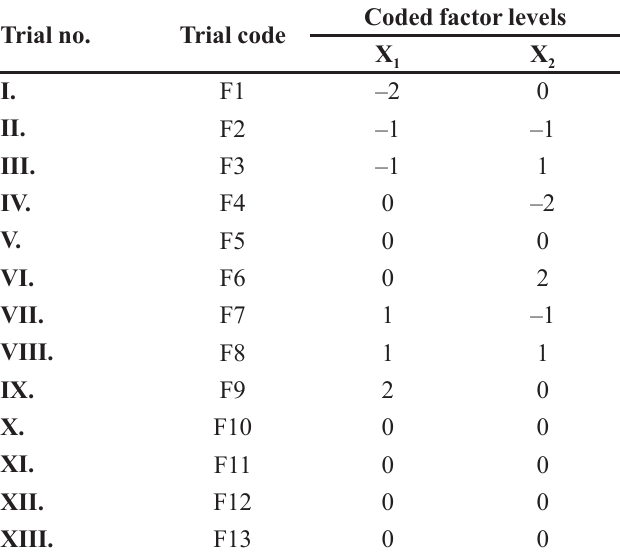
TABLE III - Different combination of factors for the experimental design selected Trial